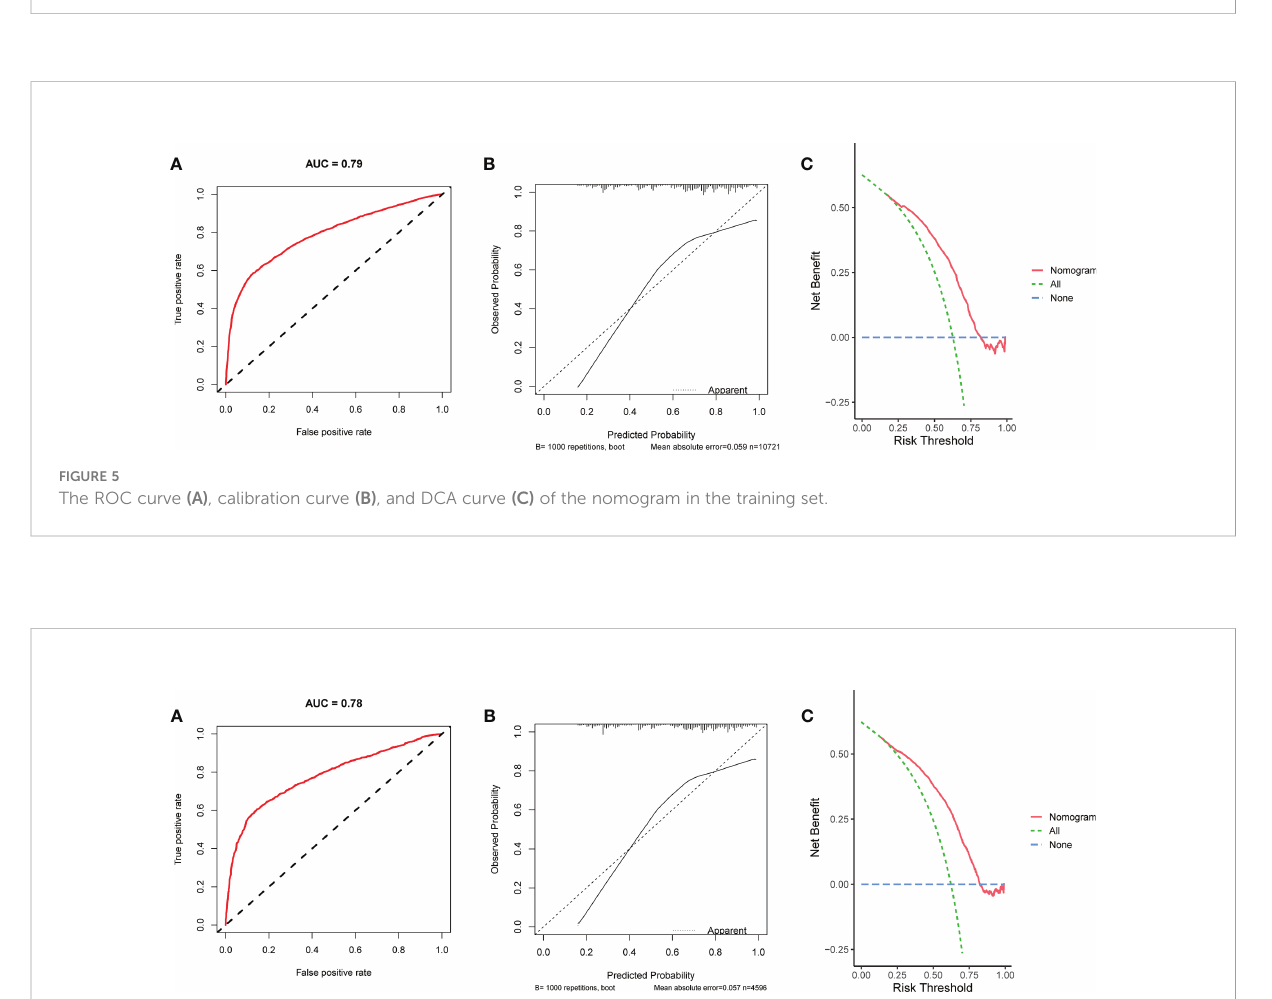
FIGURE 6 The ROC curve (A) , calibration curve (B) , and DCA curve (C) of the nomogram in the internal validation